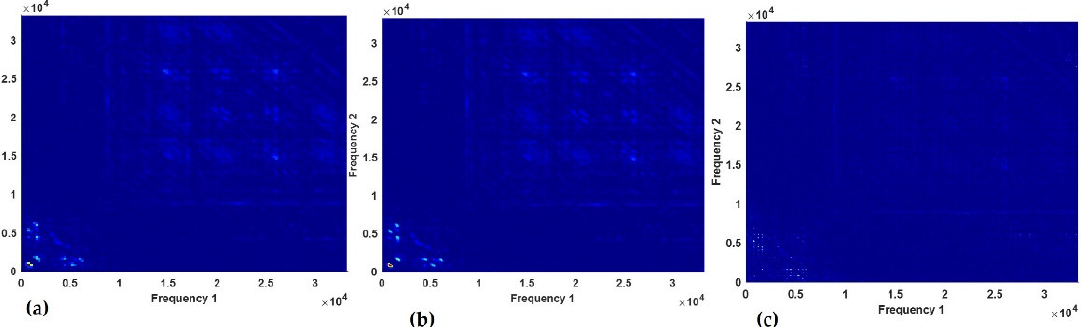
Figure 8. Cyclic spectral coherence maps for unbalance shaft at window size: ( a ) 128, ( b ) 256, ( c ) 512, and ( d ) 1024.